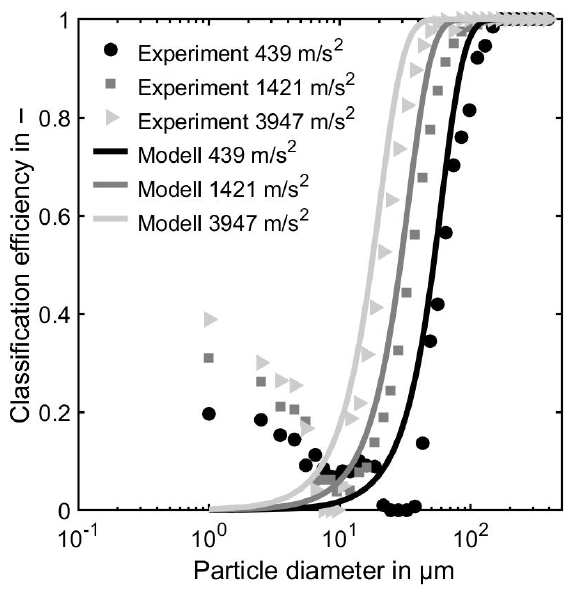
Figure 10. The comparison between the cut size curve of the model and the experiment for different classifier accelerations.